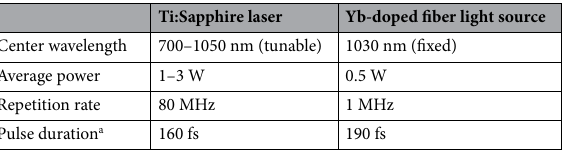
Table 1. The parameters of laser output. a Full width at half maximum (FWHM), assuming a Gaussian